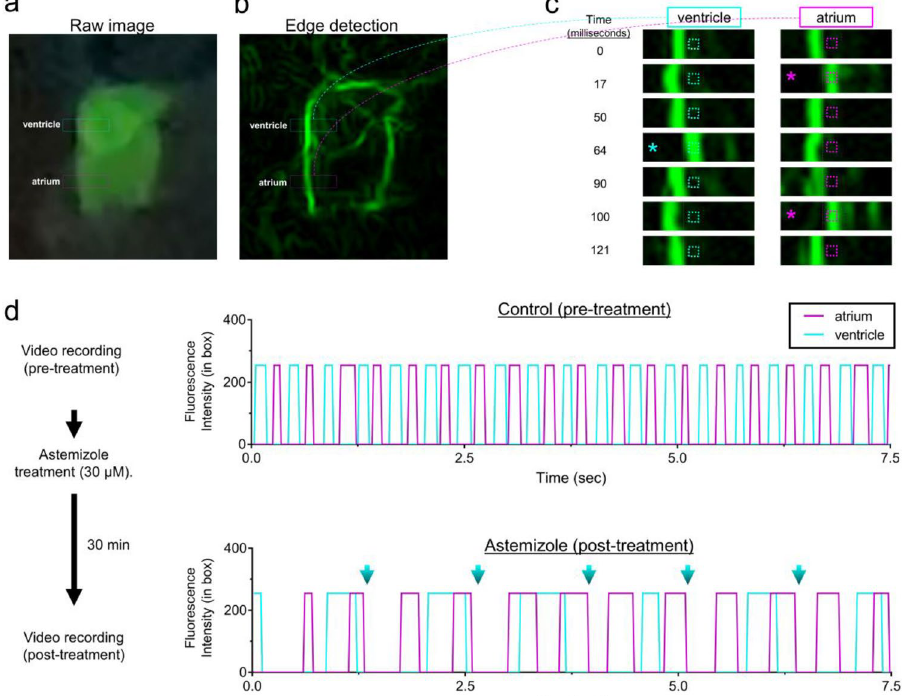
Figure 6. Glowscope detection of drug-induced cardiac arrythmia. ( a–b ) Still images from a glowscope video (acquired on an iPhone 11 Pro) show atrium and ventricle chambers in a 3 dpf Tg(myl7:EGFP) zebrafish embryo. Images show either the raw (unedited) view of heart fluorescence directly from smartphone video recording ( a ) or a processed view of the same heart after edge detection was performed on a computer using Fiji ( b ). Blue and magenta rectangles show the regions of ventricle and atrium chambers used for high- magnification viewing and analysis in ( c–d ) . ( c ) Images show a timecourse (top to bottom) of ventricle (left) or atrium (right) chamber movements detected by the glowscope (corresponding to boxed regions in panel b ). The small, dash-boxed regions of interest were used to monitor fluorescence intensity changes over time. Asterisks highlight frames where the heart chamber wall has moved into the region of interest with respect to the prior frame. ( d ) Graphs of fluorescence intensity vs. time plotted for atrium and ventricle chamber reveals oscillating chamber movements. Measurements within the same embryo (N = 1) were separately acquired and analyzed before (upper) and after astemizole treatment (lower). The maximum fluorescence intensity (in arbitrary units) within the dash-boxed region of interest shown in panel ( c ) was obtained and plotted for each time frame of the video recording, resulting in a fluorescence peak each time the chamber fluorescence entered and occupied the boxed region of interest. Note the differences in both heart rate between control and astemizole-treated hearts as well as the arrhythmic 2:1 atrial:ventricular beat pattern induced by astemizole treatment (lower plot, 30 µM). Blue arrows in panel ( d ) show missed ventricular beats. Videos available in Supplementary Video